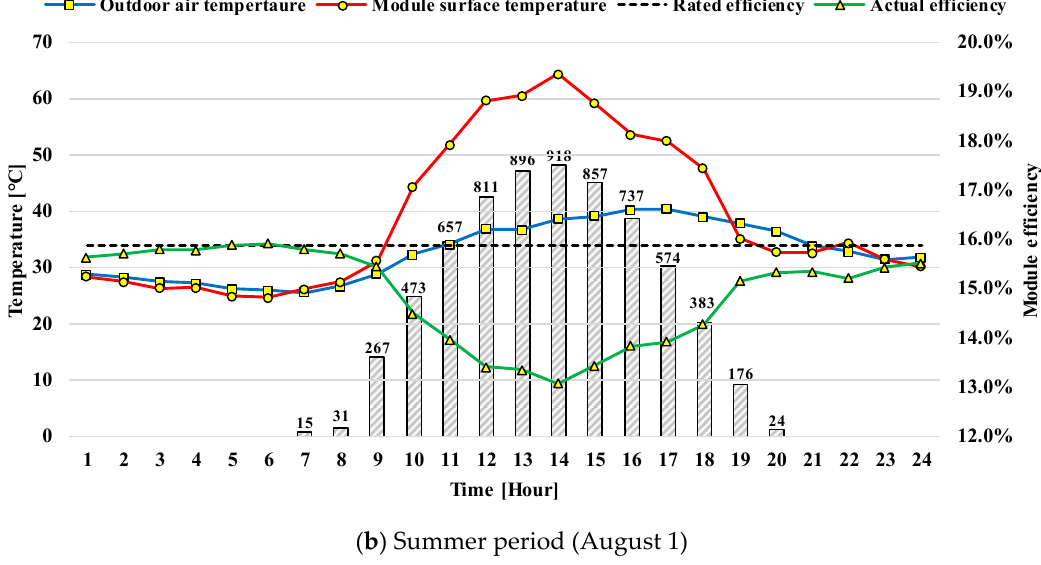
Figure 10. Module efficiency according to the module surface temperature. Figure 10. Module e ffi ciency according to the module surface